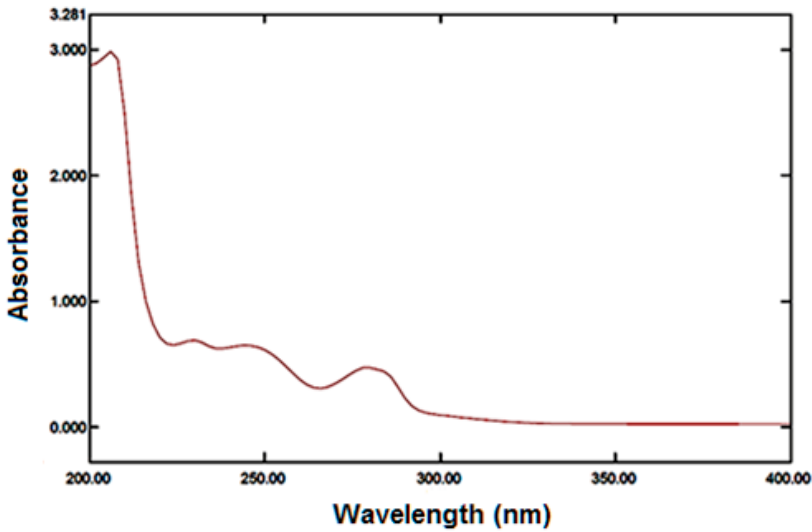
Figure 2. UV Spectrophotometric scans for FLB solution.